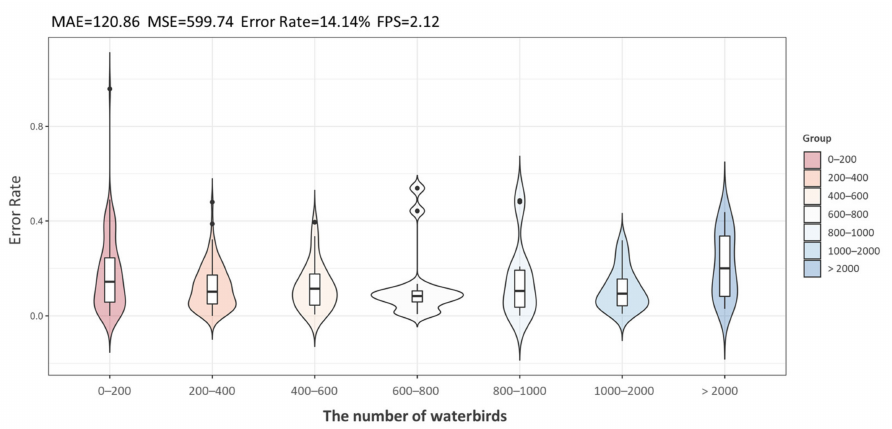
Figure 7. Distribution of absolute error rates in each group. The x -axis represents a grouping of panoramic images of different bird populations of magnitude. The number of birds contained in the panoramic image has different effects on the accuracy of the model.